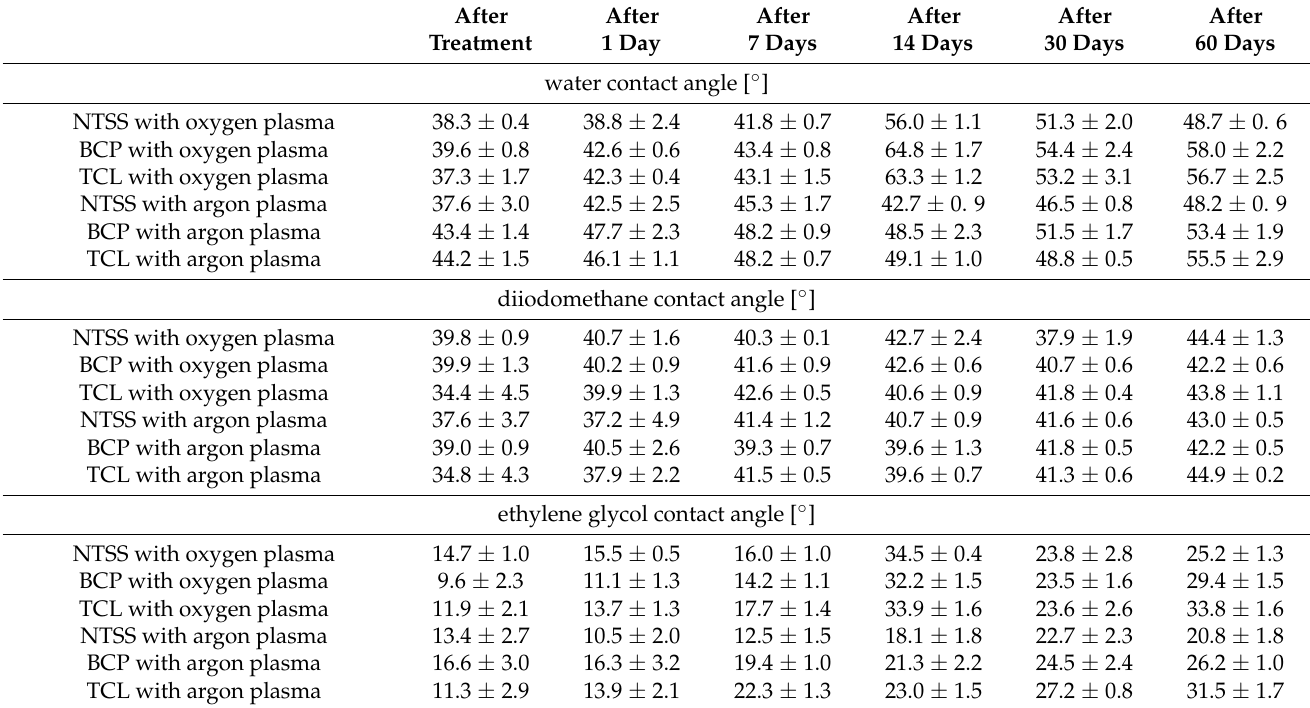
Table 2. Contact angle values for water, diiodomethane, and ethylene glycol of samples after plasma activation and during storage. After